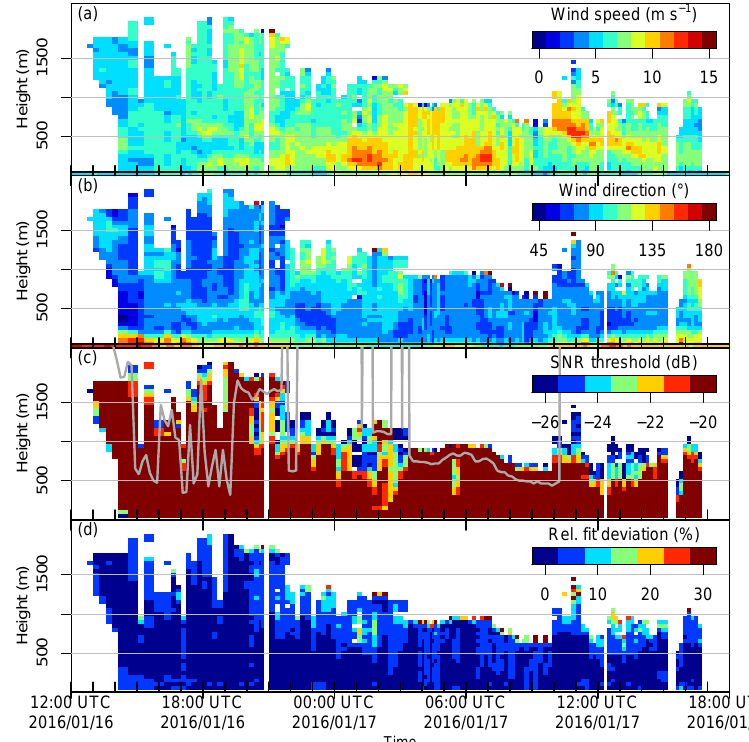
Figure 11. As Fig. 9 but for 16 and 17 January 2016 (Antarctic, PS96) and with a − 26dB SNR threshold.